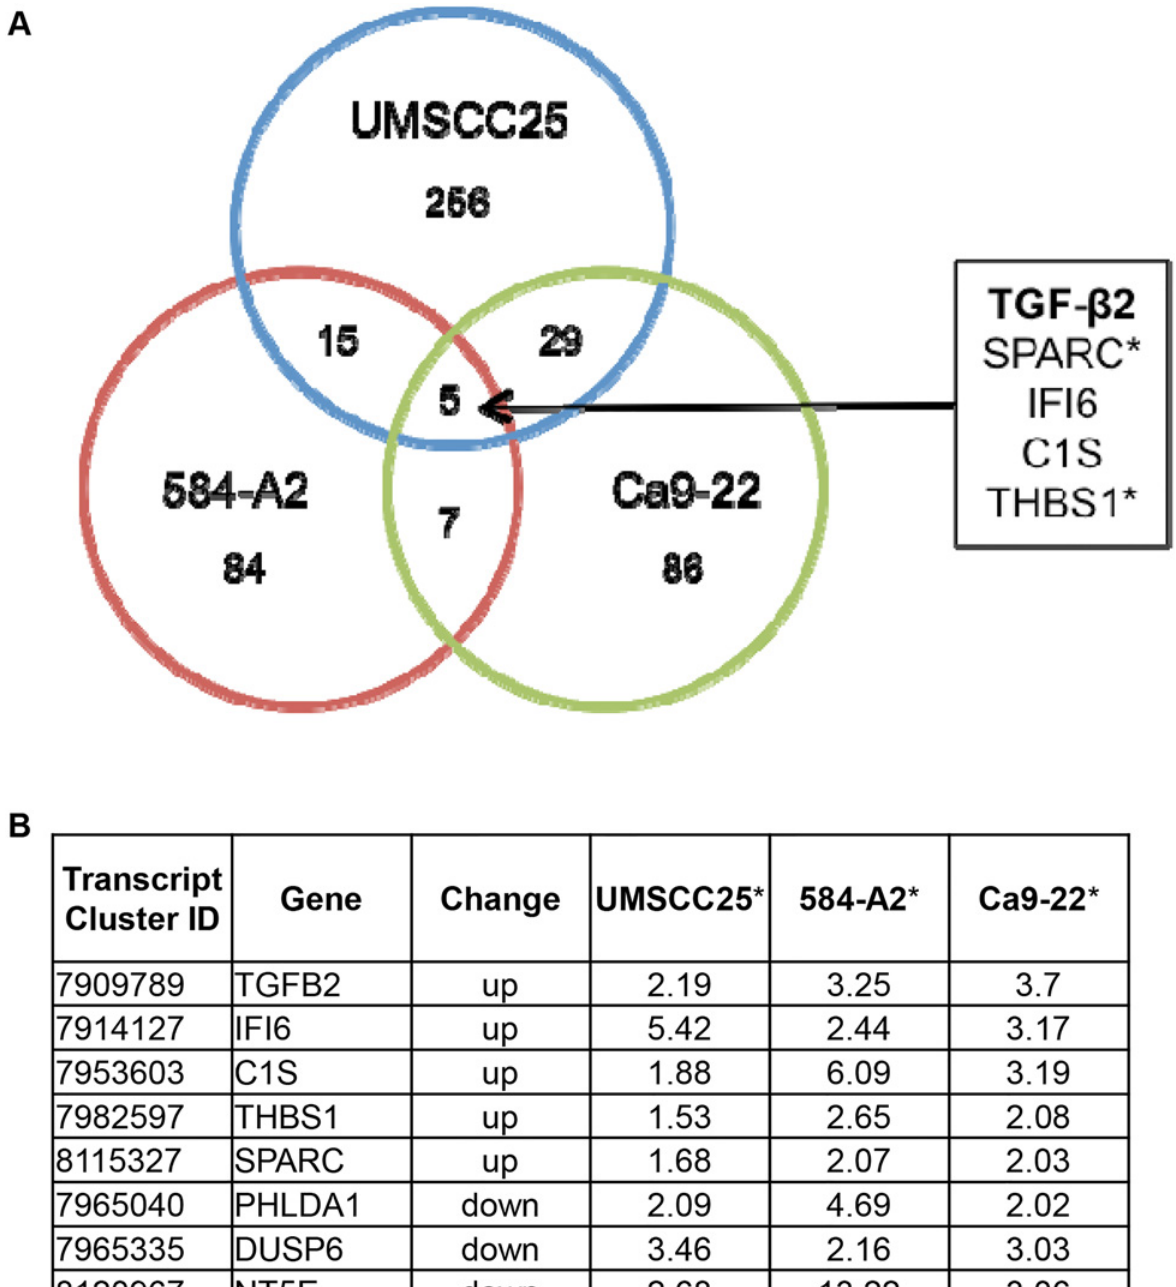
Fig 1. Comparison of genes upregulated after AZD8010 and Gefitinib treatment. RNA and protein was isolated from UMSCC25, 584-A2, and Ca9-22 HNSCC cell lines that were treated for 4 days with DMSO (control), 0.3M AZD8010, 0.1M gefitinib, or both AZD8010 and gefitinib. RNA was submitted to an Affymetrix GeneChip analysis and revealed 5 genes that were upregulated in common with AZD8010 and gefitinib. The genes identified had either a > 2 (UMSCC25 and Ca9-22) or > 1.5 (584-A2) fold change in expression levels compared to the DMSO control. A. A venn diagram showing the genes upregulated in all the cell lines. B. Tabulated values for the genes increased and decreased in the AZD8010 and gefitinib treated group. * Numbers are the fold change in the treated compared to the control. TKIs: AZD8010 is an FGF receptor inhibitor and gefitinib is an EGF receptor inhibitor.